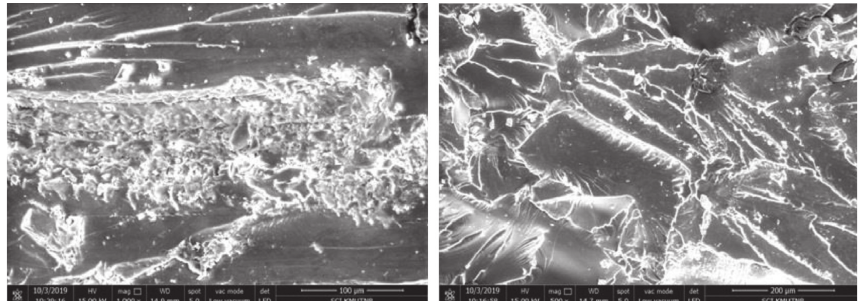
Figure 6: Impact fracture SEM image depicting agglomeration of the